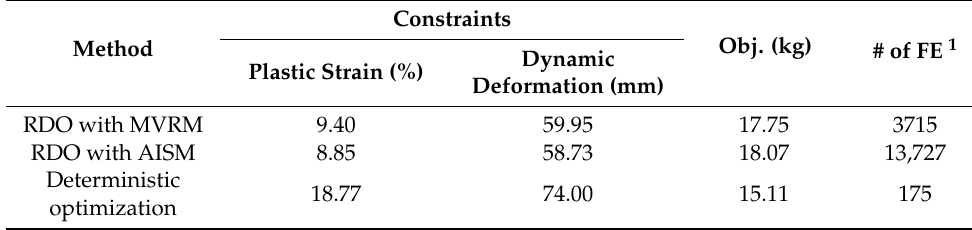
Table 5. Comparison of objective and constraint